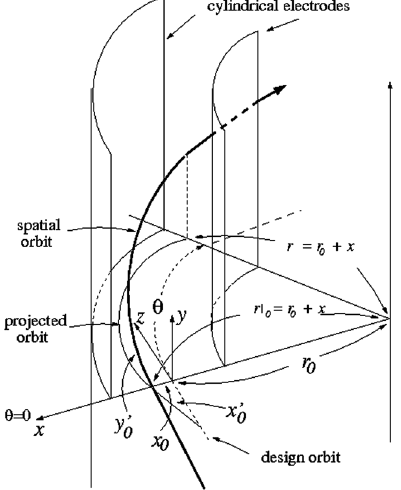
FIG. 2. The bold curve shows a particle orbit passing through a curved-planar cylindrical , m ¼ 0 , electrostatic bending element. The electrode spacing is g and the design orbit is centered between the electrodes in the y ¼ 0